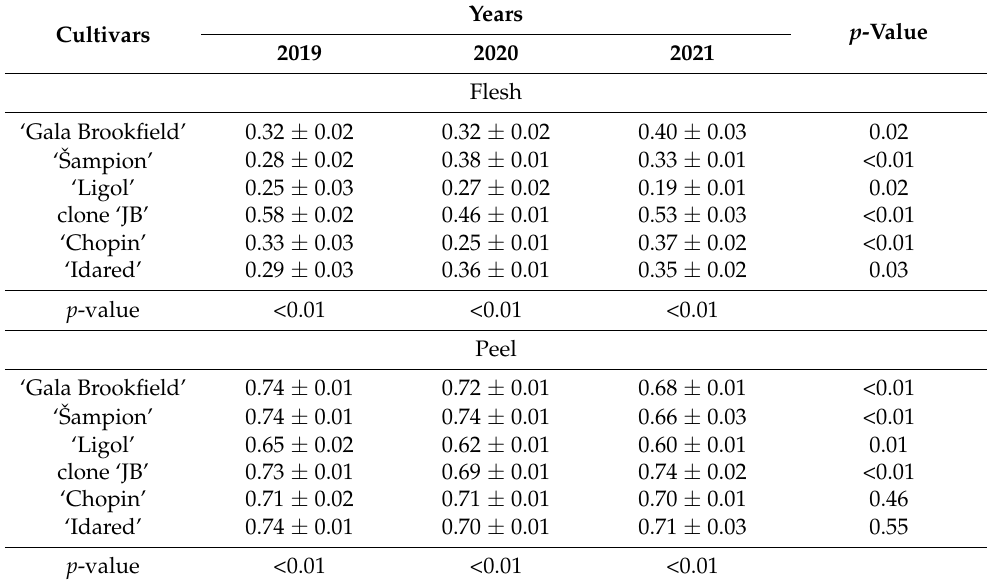
Table 10. The values of antioxidant activity (mg AAE · 100 g − 1 FW) for flesh and peel of apples depending on cultivars and years of